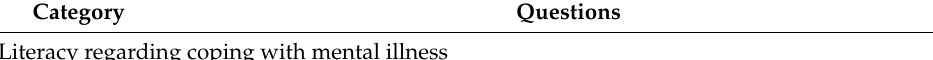
Table A1. Outline of the